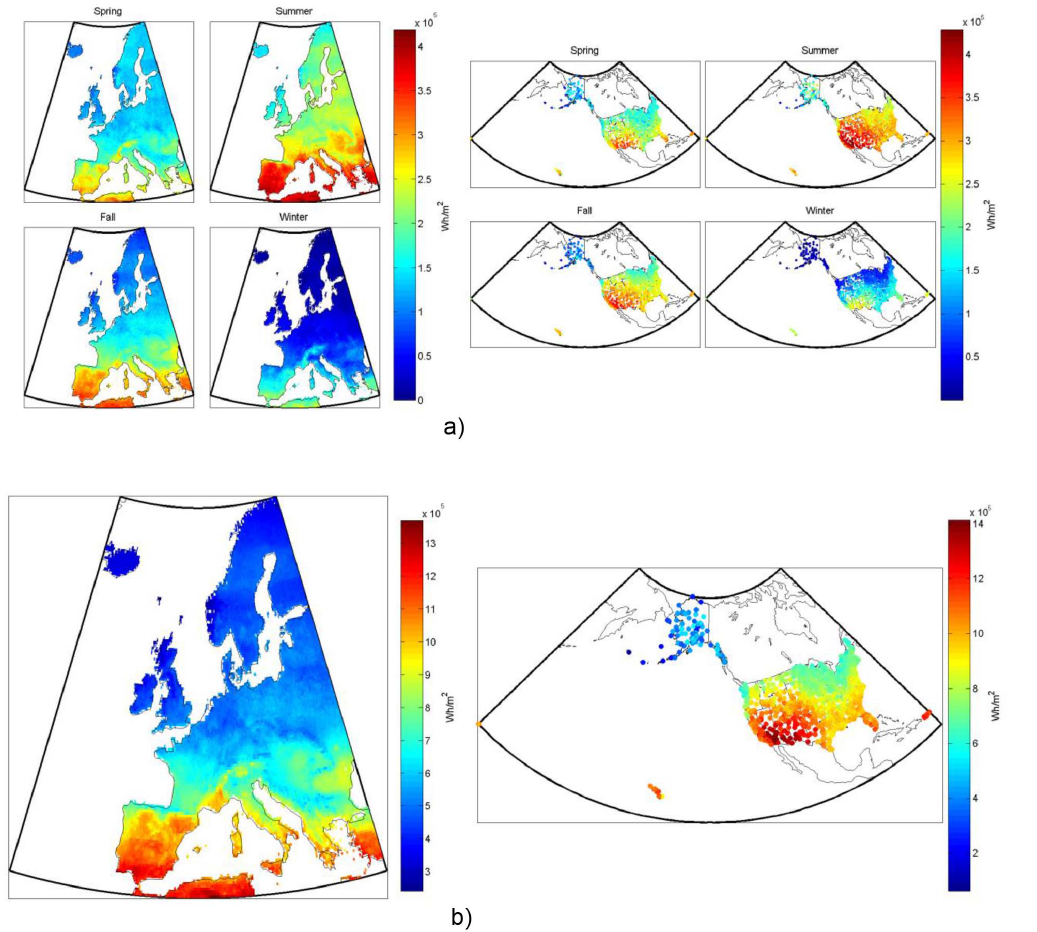
Figure 3. Non-tracking flat-plate thermal system’s heat production, from one square meter of collector, both (a) seasonally and (b) annually in (left) Europe and (right) the